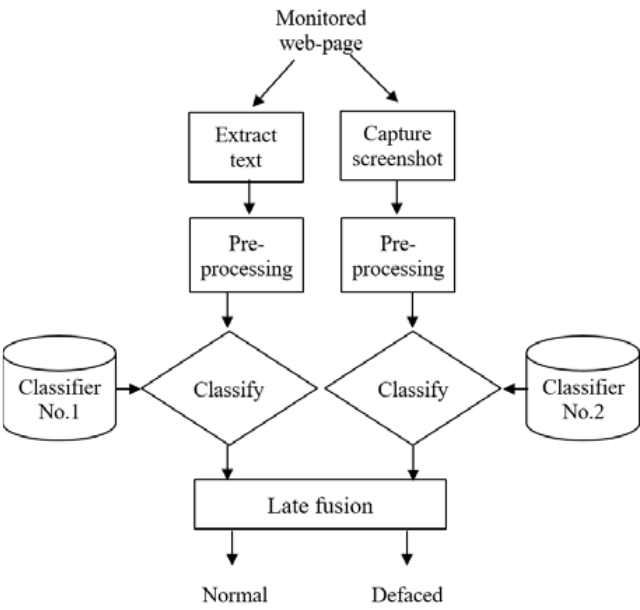
Figure 8. The proposed combination model: detection phase [26].